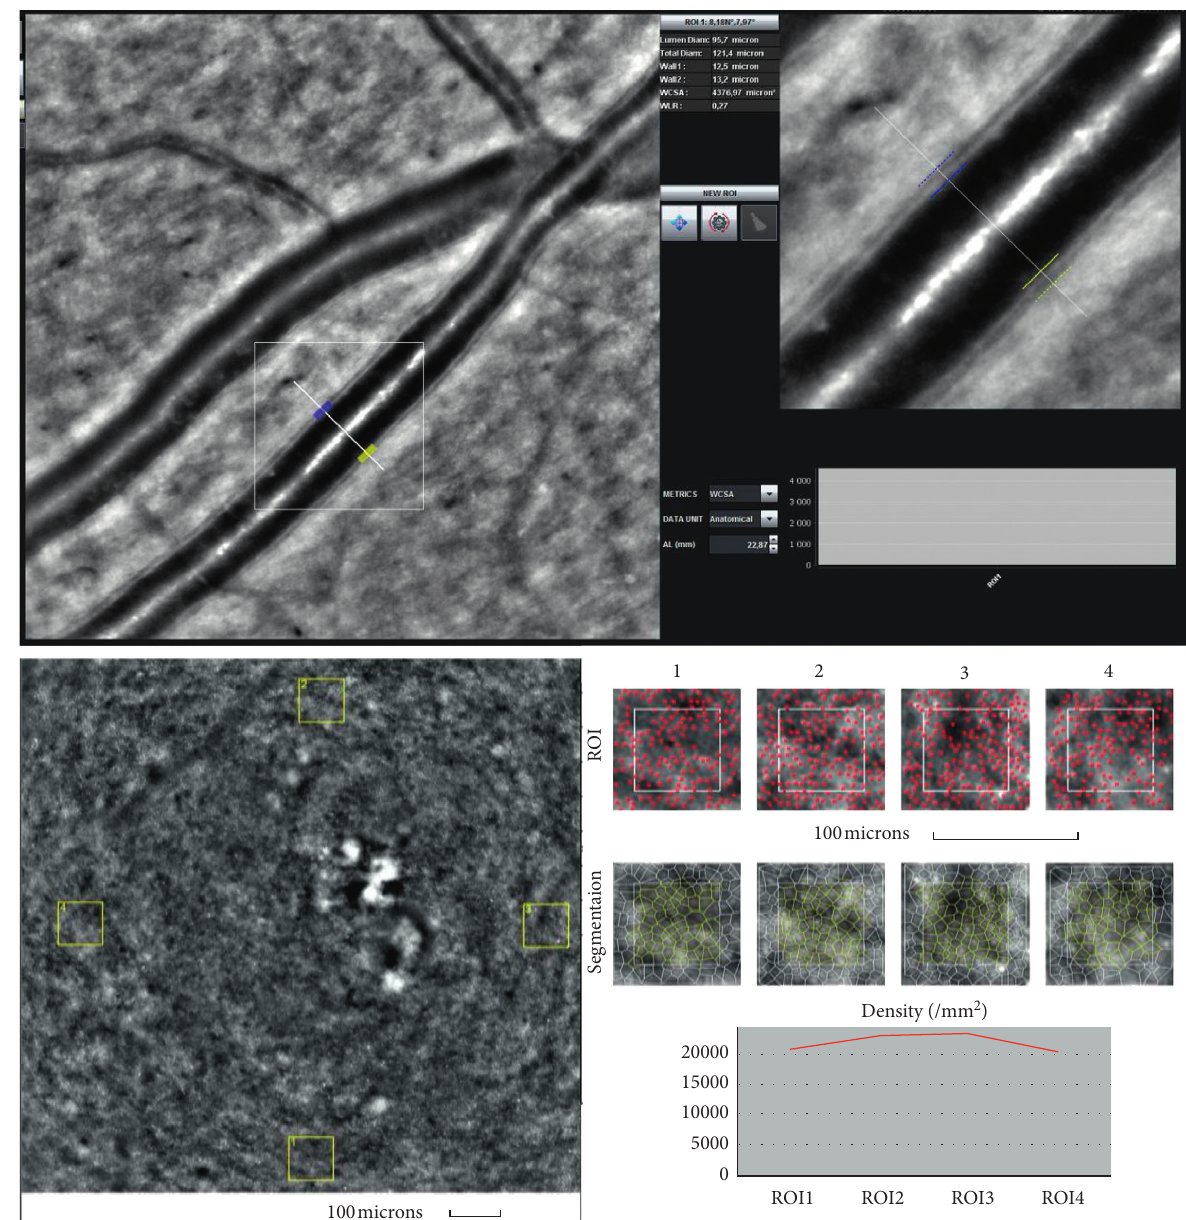
Figure 2: Image of the retinal artery (upper) and of four retinal cones squares windows (cones depicted in red and Voronoi triangulation) (lower) for a patient from the control group (IK) captured by rtx1 AO retinal camera. The following parameters are shown: in the